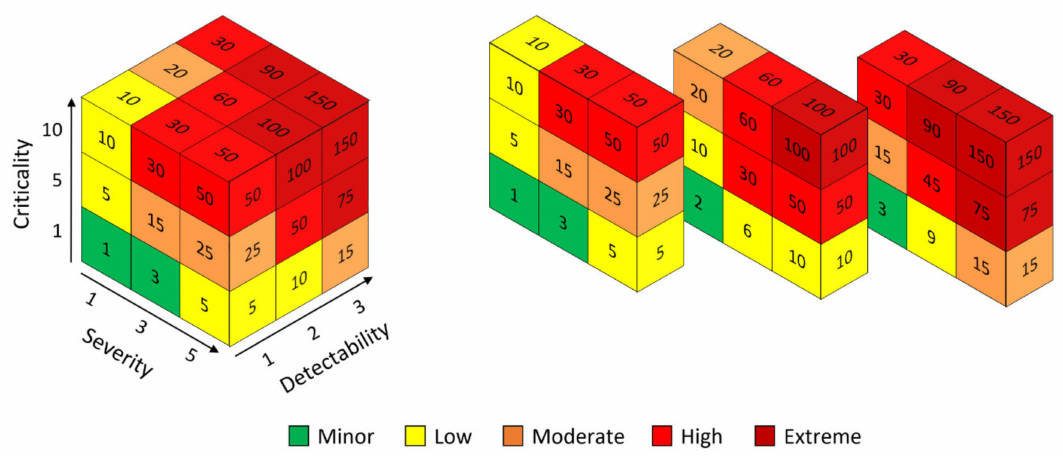
Figure 8. Contextual factor matrix. Table 11. Correlation matrix for contextual factor to cofactor